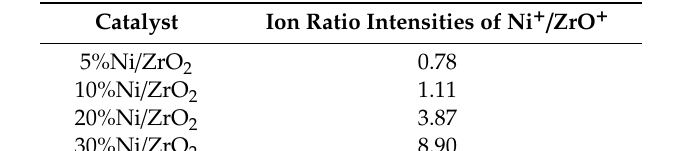
Table 7. The relation between the intensity of selected ions and the nickel content estimated by TOF-SIMS measurements.